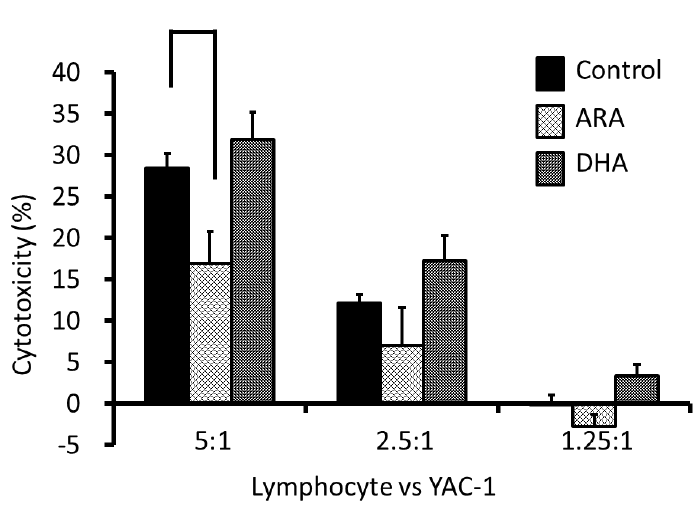
Figure 1. Cytotoxicity of natural killer (NK) cells in rat spleen lymphocytes against YAC-1 cells. The cytotoxicity levels in YAC-1 cells caused by NK cells in spleen lymphocytes after 24 h coculture in the y -axis. The ratio of the mixture of lymphocytes and YAC-1 is presented on the x -axis. The relative cytotoxicity levels are expressed as the mean ± S.E. ( n = 6). * significant at p < 0.05 vs. rat lymphocytes in the control group using a one-way ANOVA followed by Dunnett’s